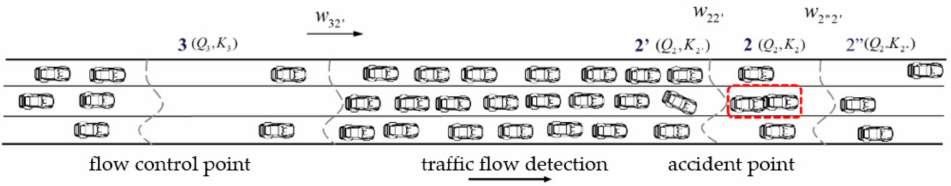
Figure 7. Diagram of traffic flow when vehicles meet queued vehicles after traffic